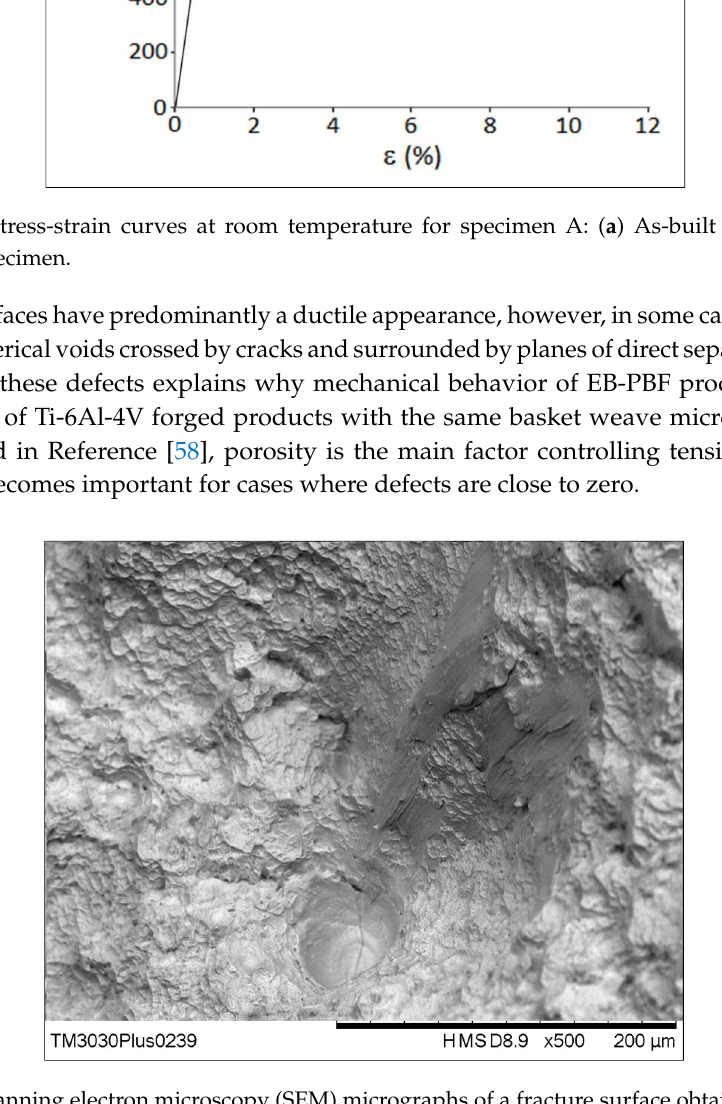
Figure 16. Scanning electron microscopy (SEM) micrographs of a fracture surface obtained by tensile test at room temperature.